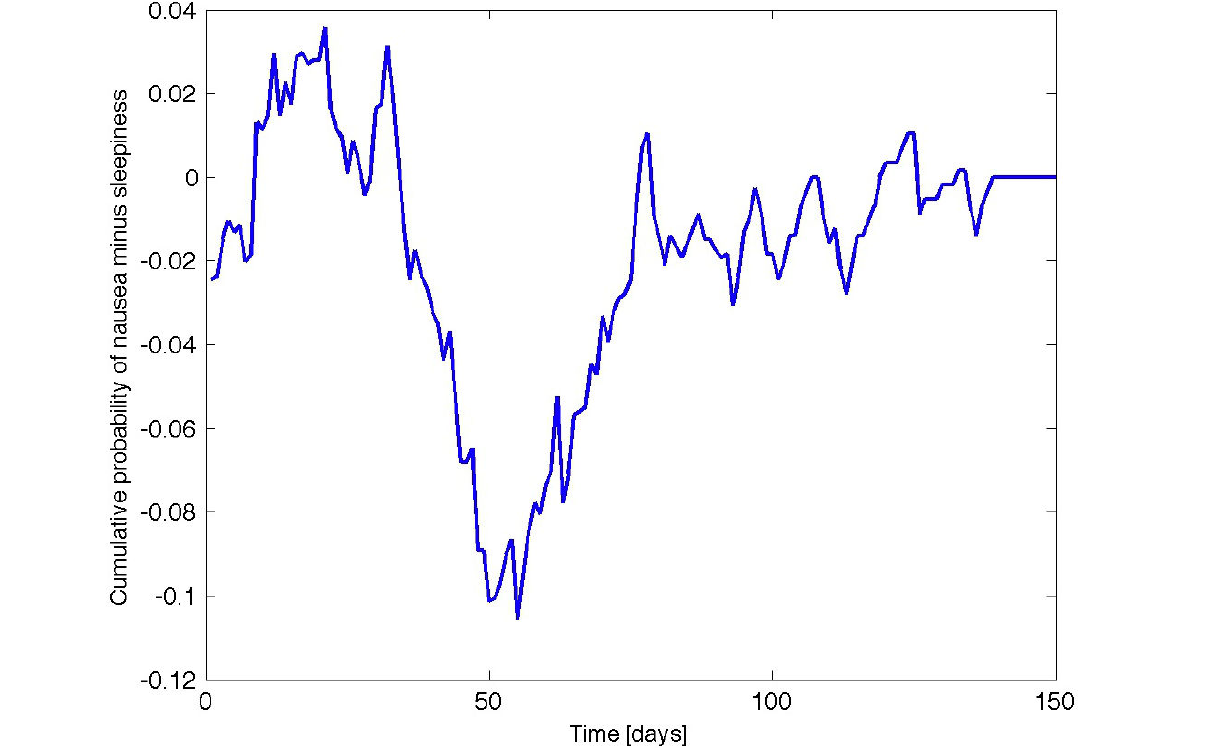
Figure 1. Temporal behavior of adverse drug reactions (ADRs). The difference between the cumulative probabilities of the ADRs “nausea” and “sleepiness” for the drug Effexor. The ADR highly ranked by QLRS (sleepiness) has a much later onset (45-75